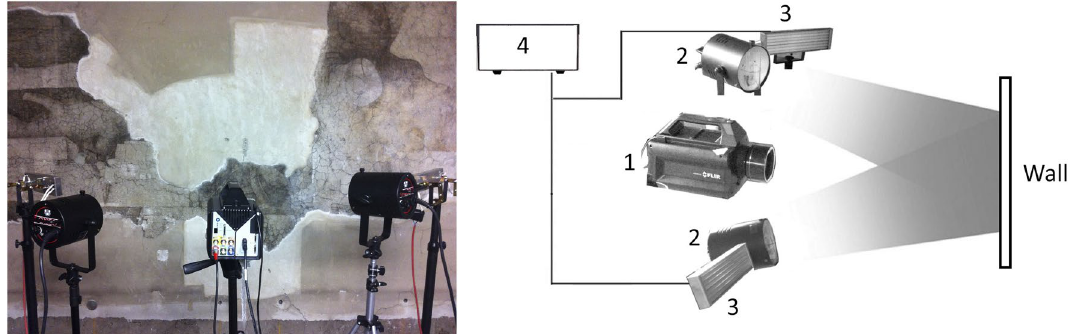
Figure 7. Dual mode measurement setup in situ (left) and sketch of the recording system: (1) IR camera, (2) halogen sources for heating the painting, (3) non-heating TQR sources matched to the sensor, (4) control unit for TQR sources.